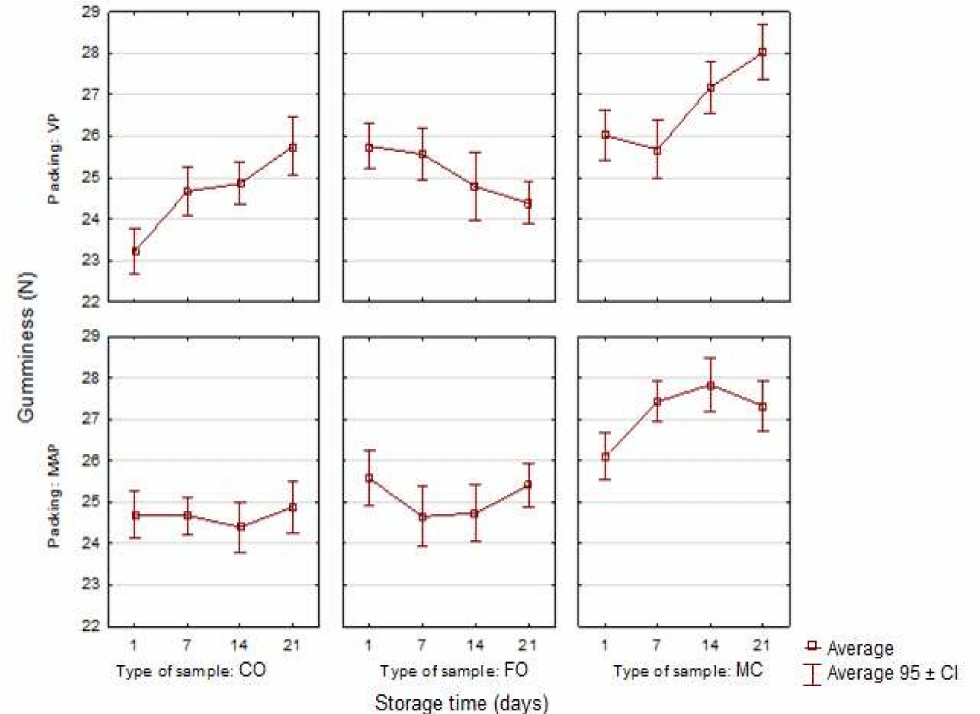
Figure 5. Changes in the gumminess in the poultry sausages depending on the type of sample, packing and storage time ( n =